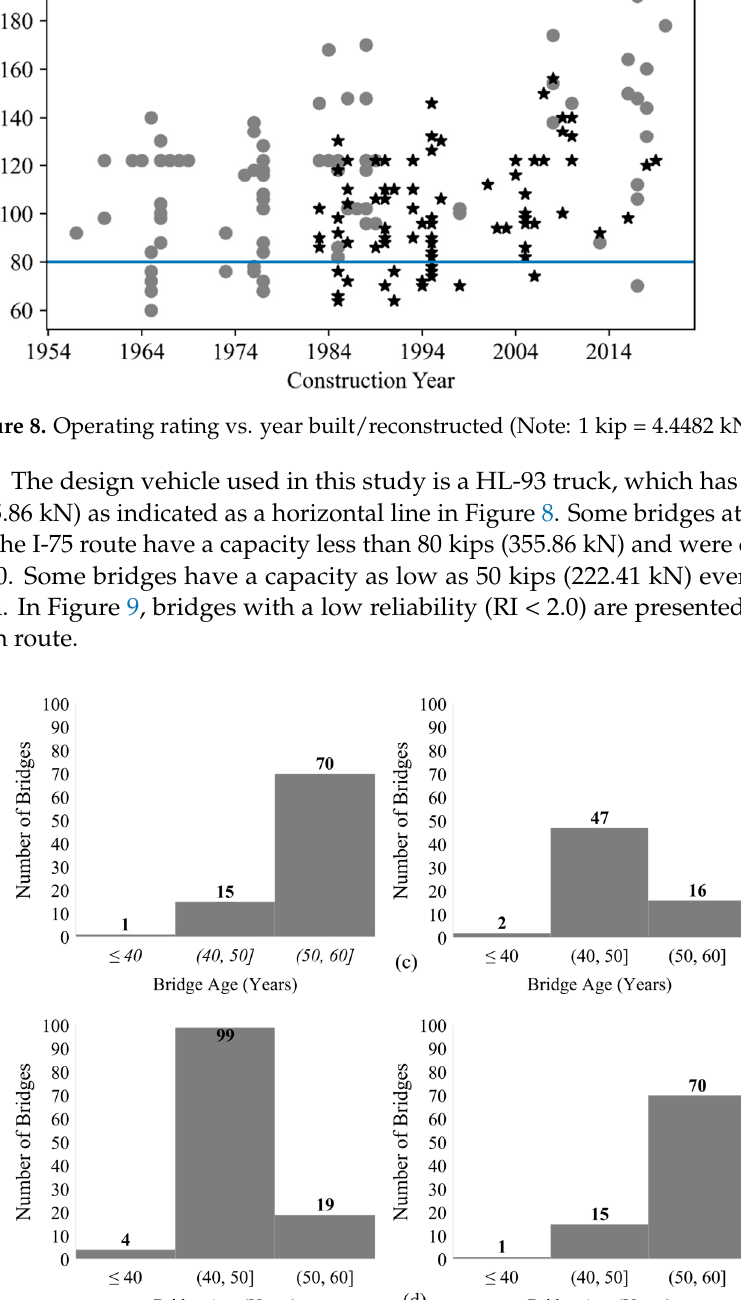
Figure 9. Histogram Showing the Number of Low Reliability (RI ≤ 2.0) Bridges by Age Groups in Routes ( a ) I-75, ( b ) I-95, ( c ) I-16, and ( d ) I-20.